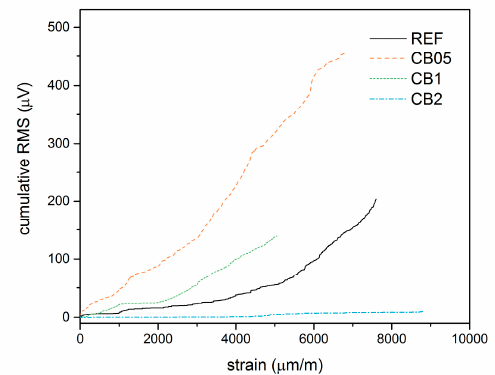
Figure 8. Comparison of cumulative RMS vs. longitudinal strain for all tested composite mixes. Data are only presented up to the maximum recorded compressive strain.